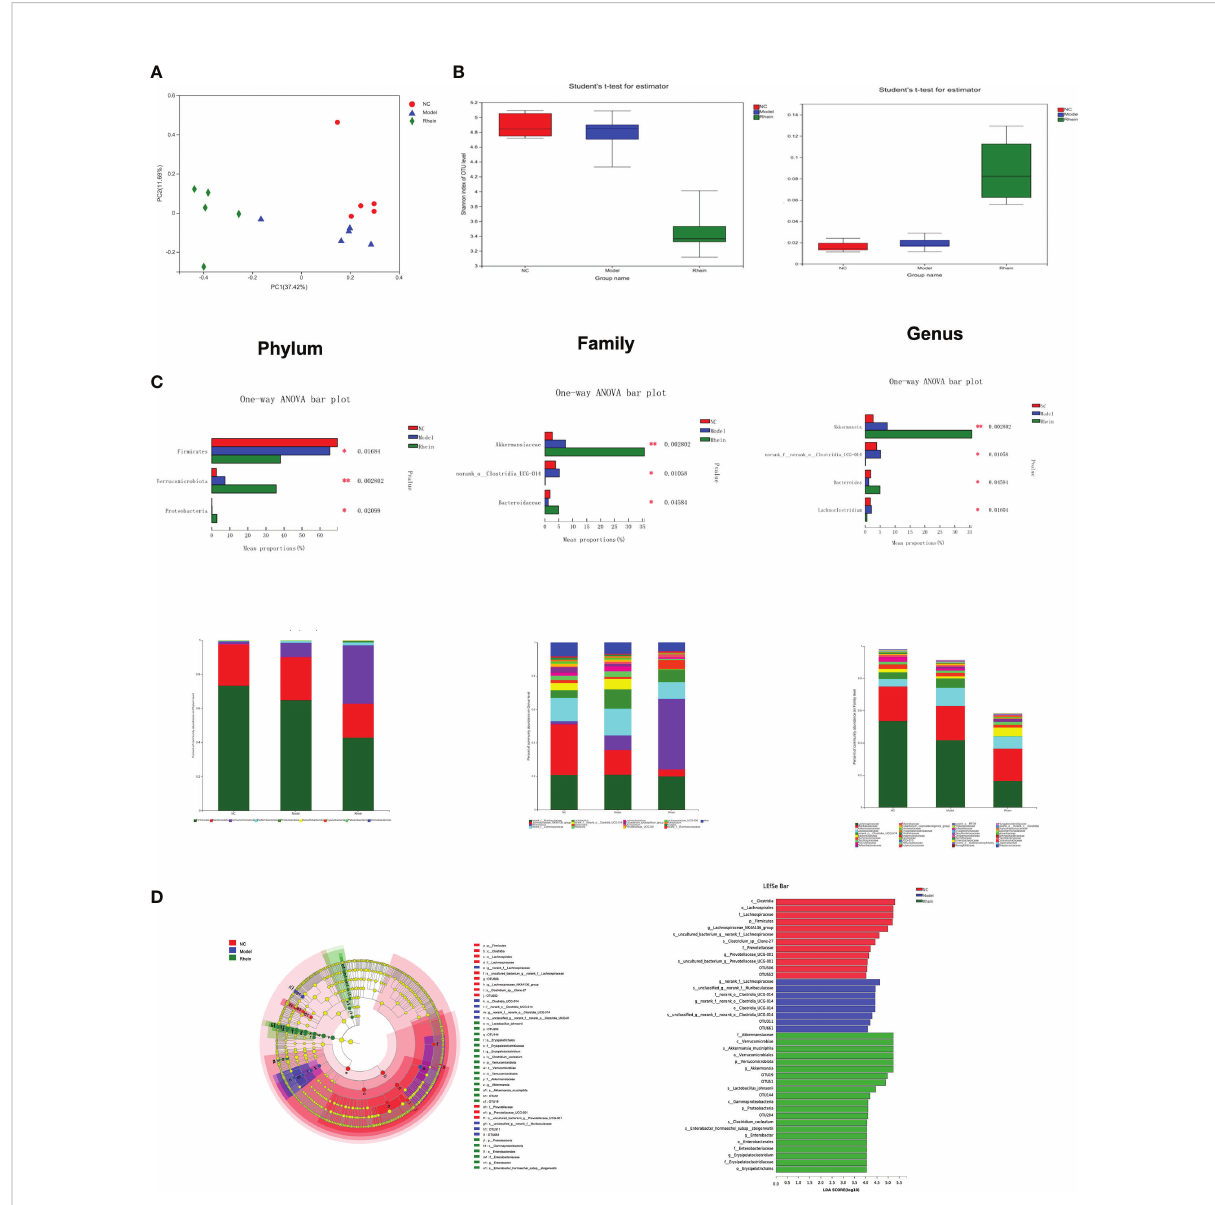
FIGURE 2 The effects of rhein on gut microbial composition and structure in mice (n =5). (A) Alpha diversity. (B) Beta diversity was determined by the Bray – Curtis distance-based principal. (C) predominant fecal microbial communities, and different bacteria at the phylum, family, and genus levels. (The symbol * indicates statistically signi fi cant differences between two groups, *p < 0.05 and **p < 0.01, one-way ANOVA). (D) The linear discriminant analysis effect size (LEfSe) analysis identi fi ed gut bacterial biomarkers in mice in three